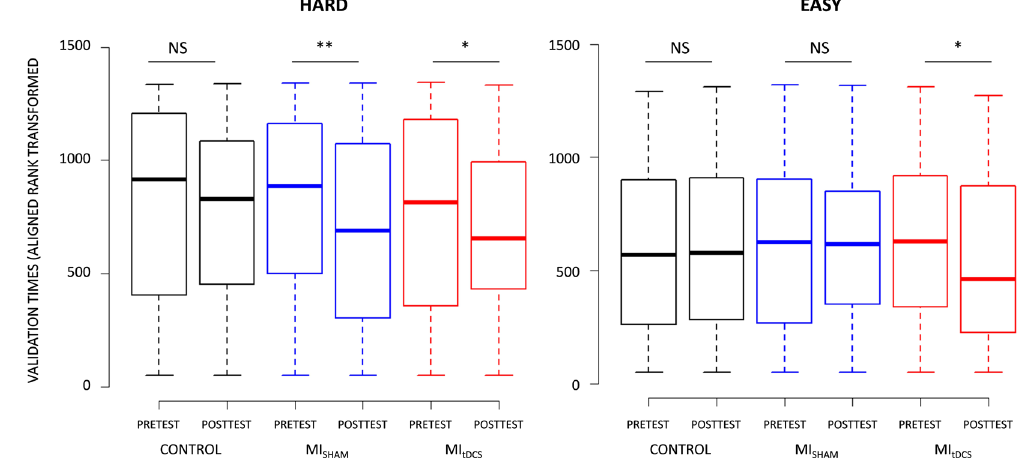
Figure 2. Effect of Control, MI SHAM and MI tDCS conditions on Easy and Hard targets validation.